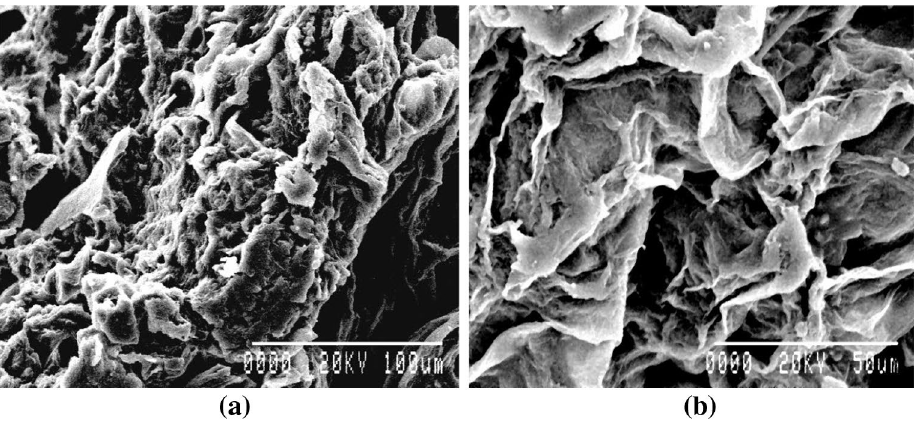
Fig. 3 a Banana peel before exposed with Congo red dye. b Banana peel after exposed with Congo red dye Fig. 4 Effect of initial concen- tration of CR dye on adsorption banana